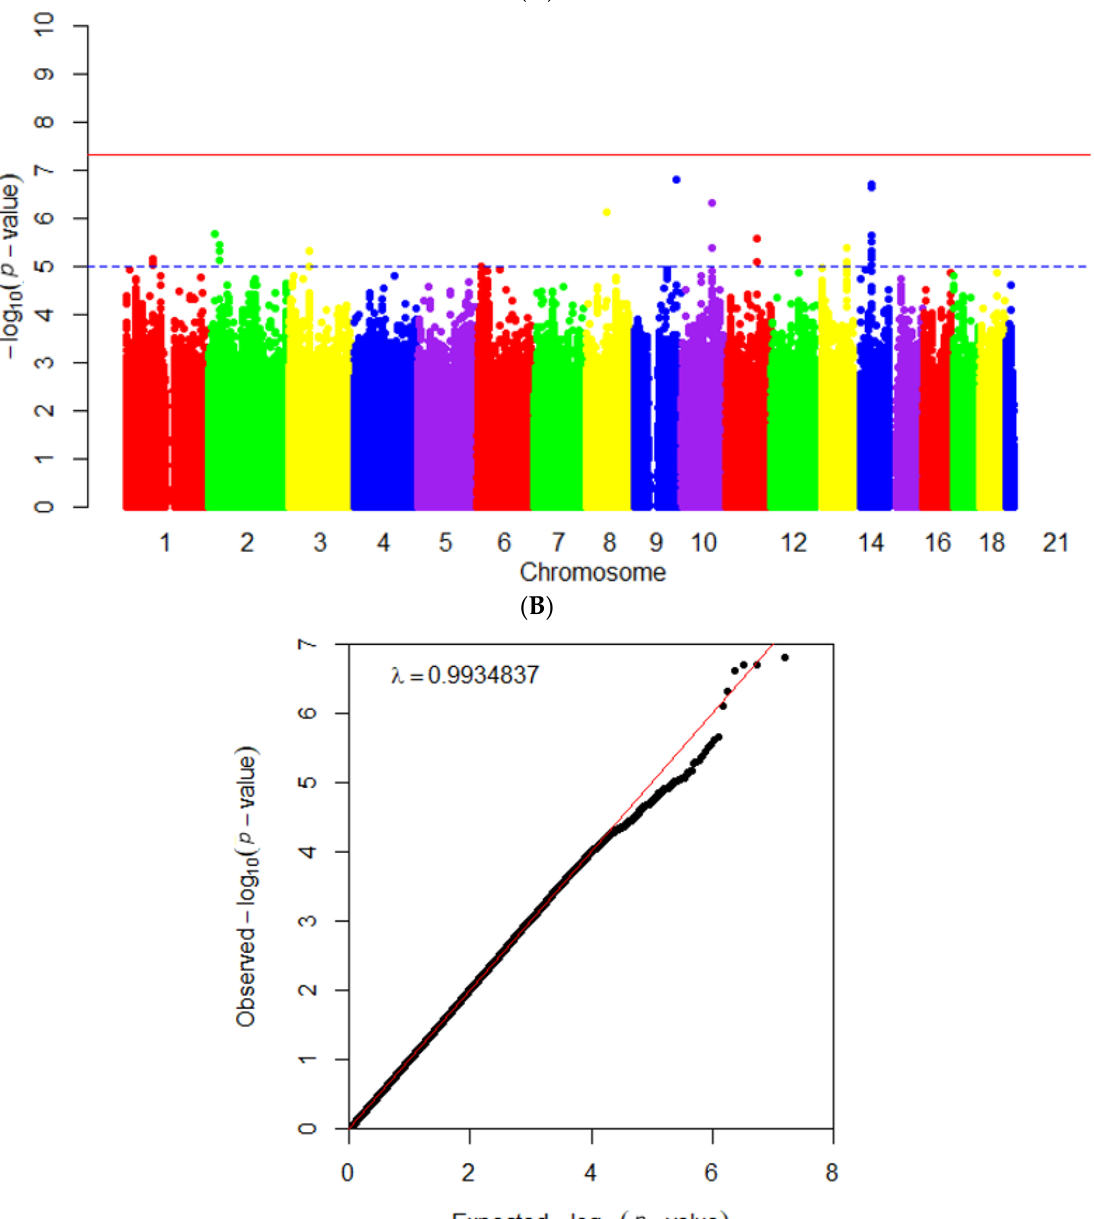
Figure 3. Manhattan and quantile–quantile (QQ) plots for single nucleotide polymorphism (SNP) association with a plant-based diet intake. ( A ) Manhattan plot; ( B ) QQ plot. The PBD intake was categorized into Low- and High-PBD groups, differentiated at the 67th percentiles. Genetic variants of the PBD intake were determined with a genome ‐ wide association study (GWAS).